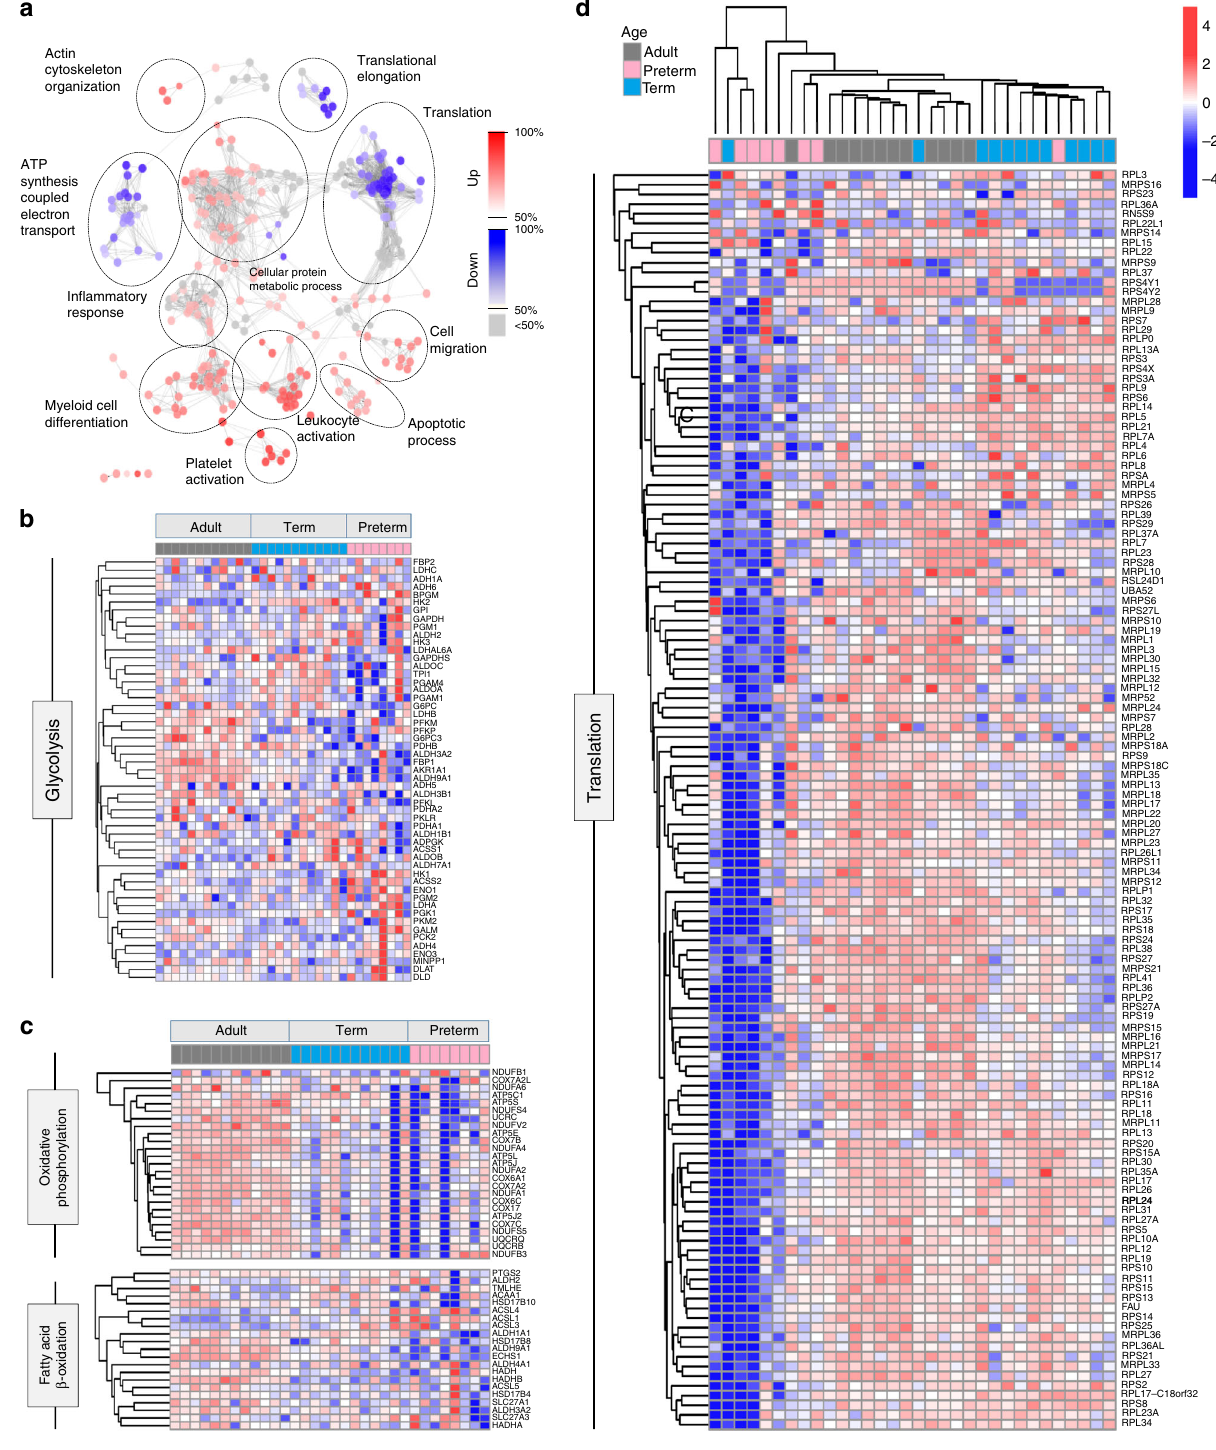
Fig. 3 Transcriptome analysis in neonatal monocytes. a Gene ontology analysis of differentially expressed genes (FDR < 0.01) between unstimulated preterm, and combined term and adult samples (monocytes; n = 8 to 12 subjects/age group); Expression heatmap and unsupervised clustering for genes involved in b glycolysis, c oxidative phosphorylation and fatty acid beta-oxidation and d ribosomal proteins. Scale represents z